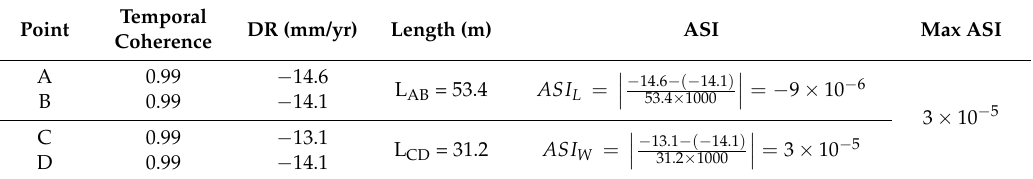
Figure 13. An example for ASI calculation for an infrastructure in the study area. Table 5. The ASI calculation for the